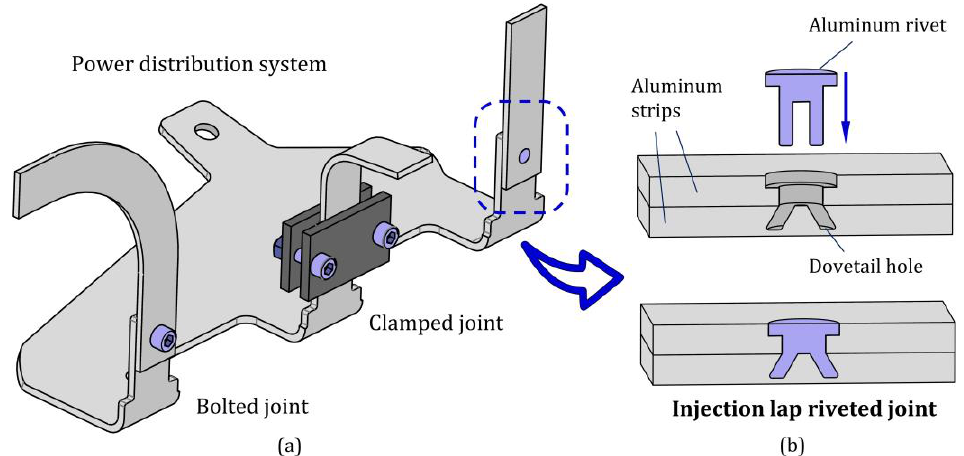
Figure 2. Busbar power distribution system with parallel connections to allow different equipment to operate independently: ( a ) examples of bolted, clamped, and injection lap riveted joints and ( b ) detail of the injection lap riveted joint showing the geometry of the rivet and dovetail hole.